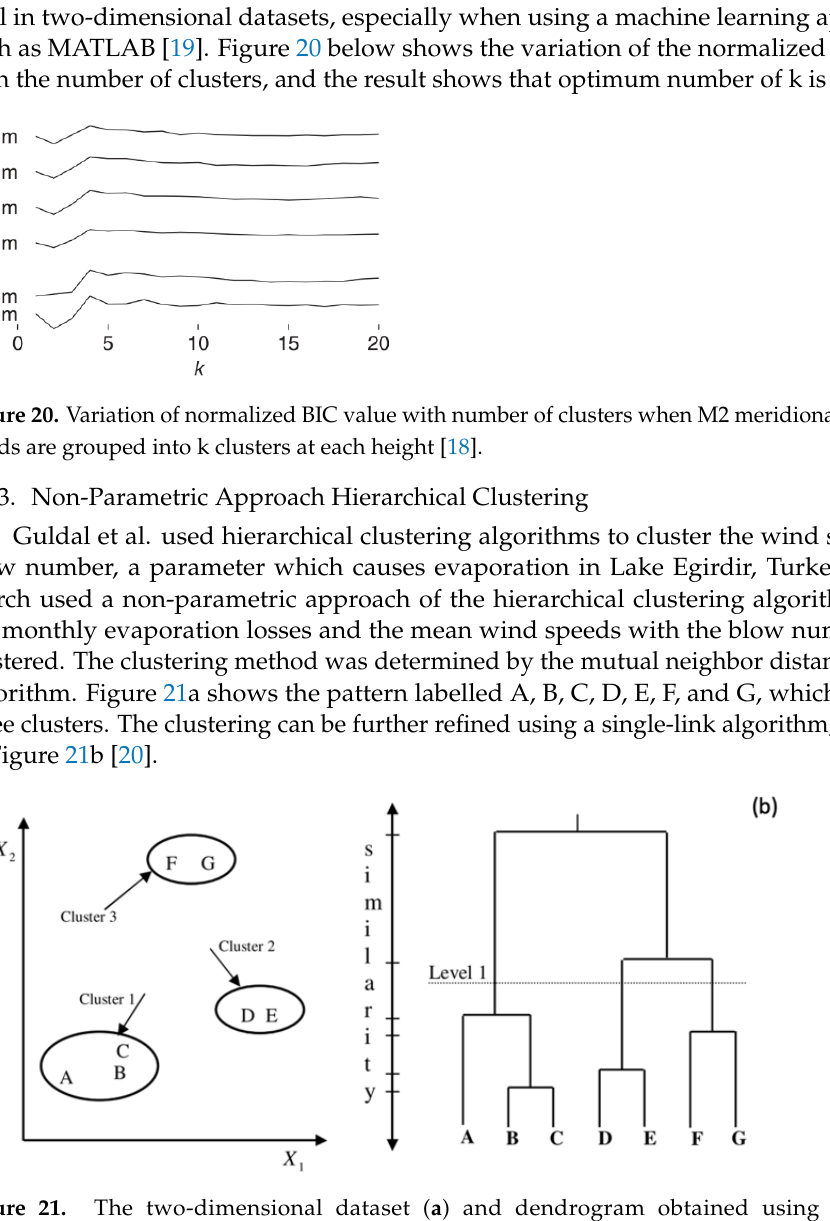
Figure 19. Optimal wind clusters at 80 m at the NWTC near Boulder [18].